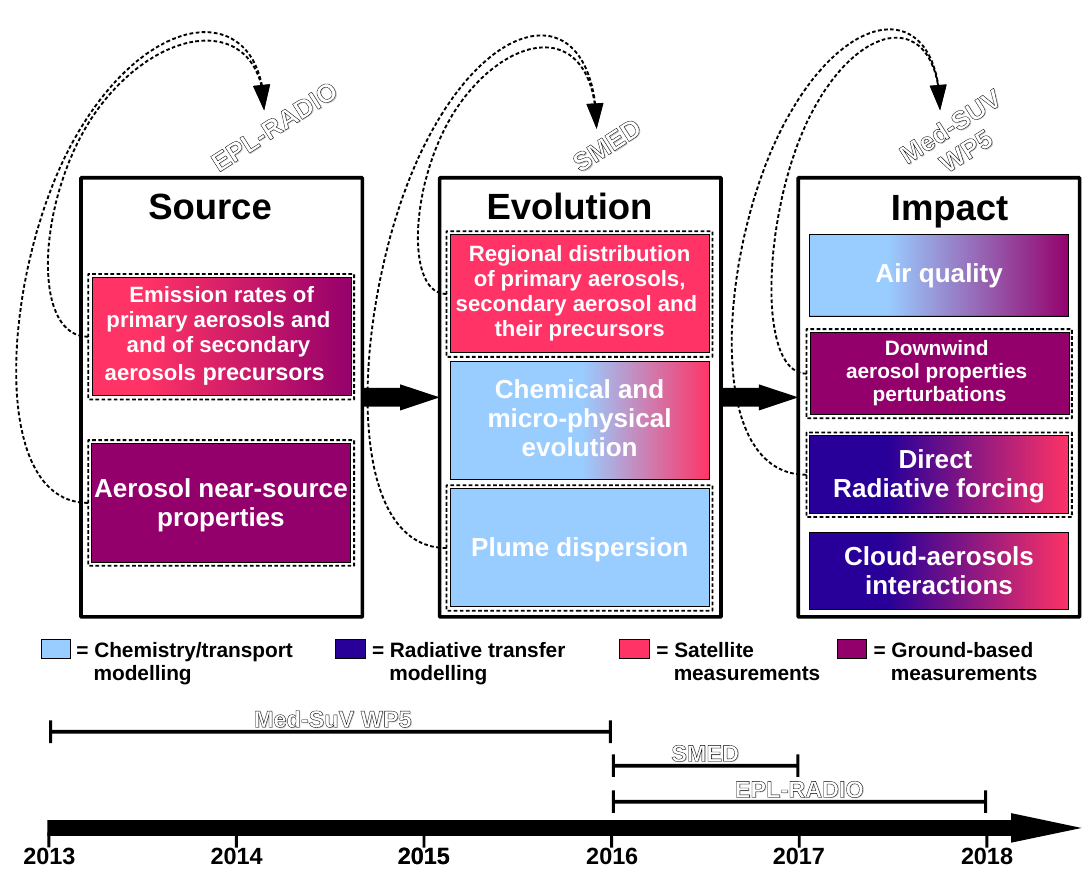
Figure 2: Breakdown of the EPL research cluster, with indication of scientific targets, methods and timeframes of the three individual modules of the